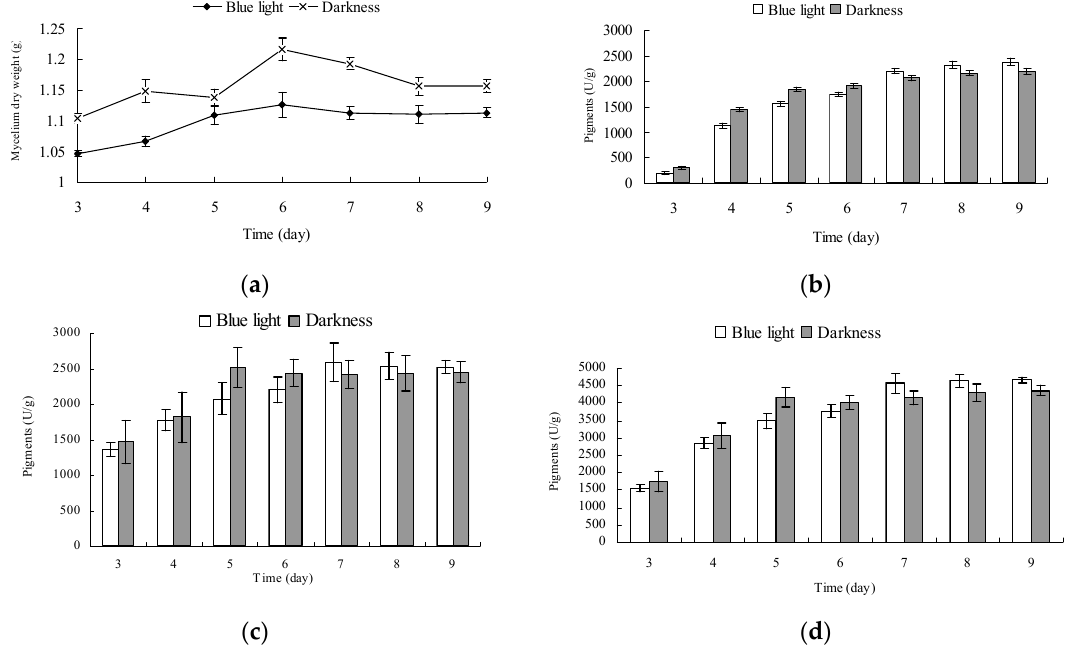
Figure 5. Effect of blue light on Monascus mycelium weight and Monascus pigment production. ( a ) Effect of blue light on the weight of Monascus mycelium; ( b – d ) Effect of blue light on Monascus pigment production in fermentation broth and Monascus mycelium, and total pigment production, respectively. Monascus was cultured by liquid oscillatory fermentation at 30 °C, 180 r/min for 9 days under blue light (0.16 mW/cm 2 ) and in darkness. The growth of mycelium and the yield of Monascus pigment production under blue light and in darkness were respectively determined by the mycelial dry weight and absorption at 510 nm.